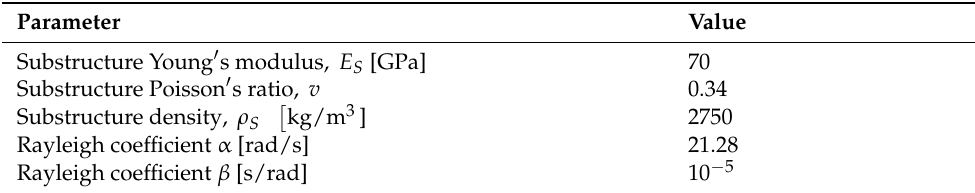
Table 3. Physical properties of the bimorph